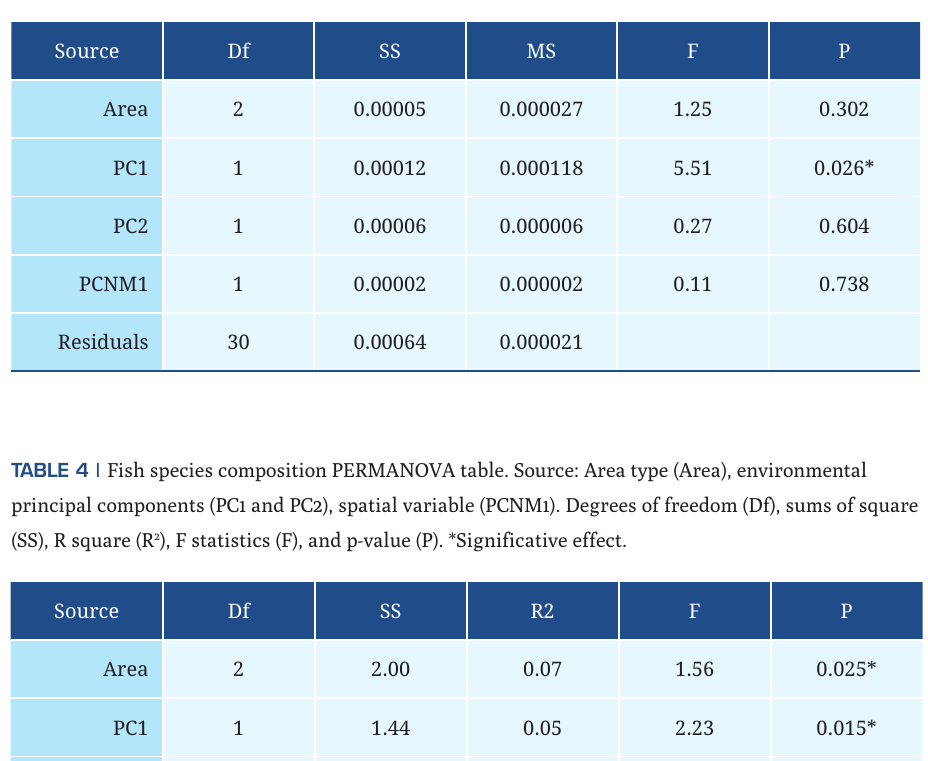
TABLE 3 | LCBD ANOVA table. Source: Area type (Area), environmental principal components (PC1 and PC2), spatial variable (PCNM1). Degrees of freedom (Df), sums of square (SS), mean squares (MS), F statistics (F), and p-value (P). *Significative effect.